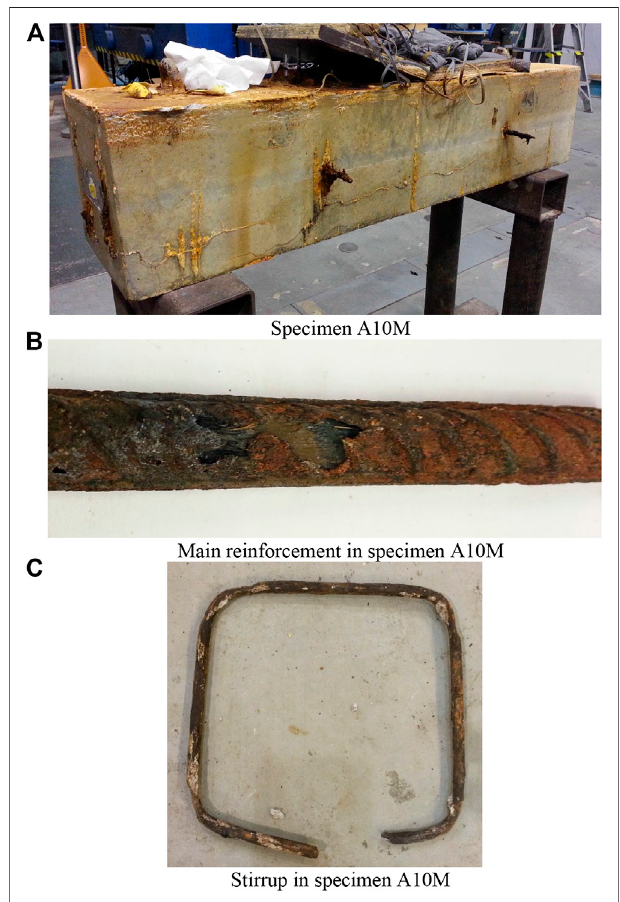
FIGURE 6 | Specimen after accelerated corrosion test. (A) Specimen A10M. (B) Main reinforcement in specimen A10M. (C) Stirrup in specimen